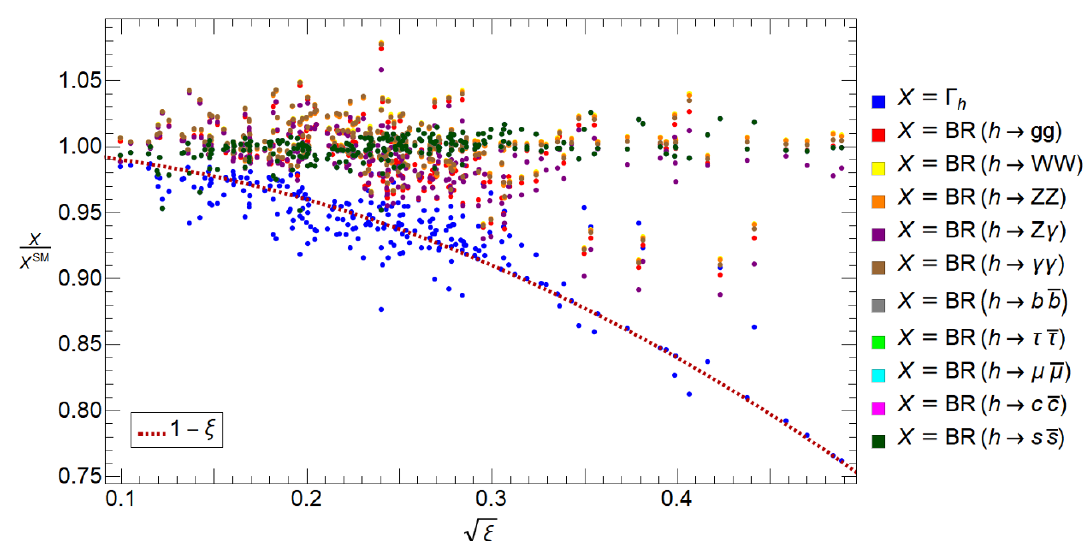
Figure 6 . Total width and branching ratios of the Higgs boson normalised to their SM values in the BP. The dotted line is 1 (cid:0) (cid:24)